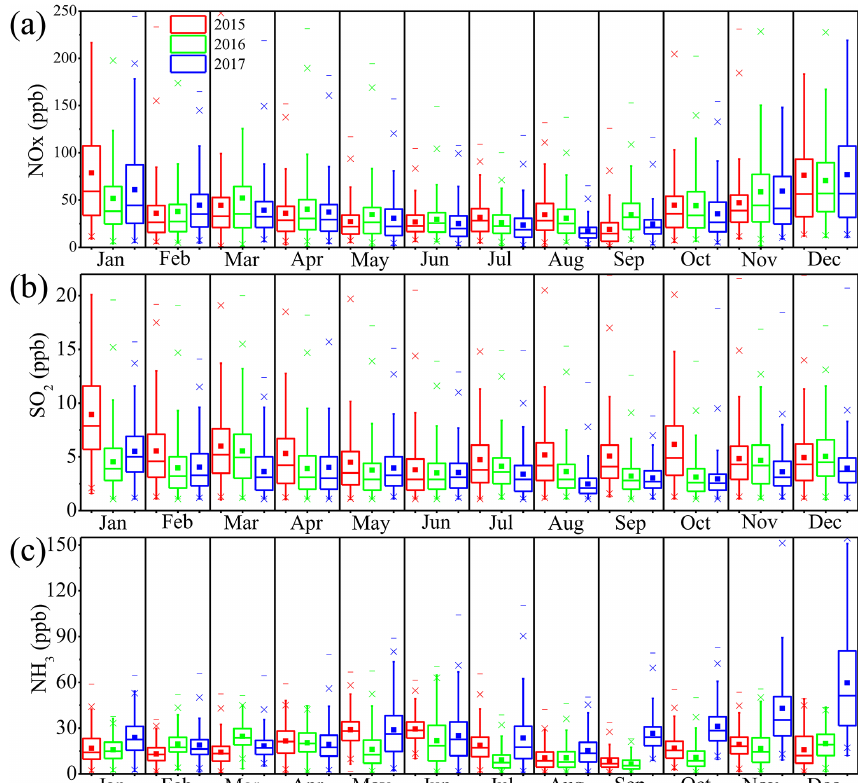
Figure 4. Monthly variations in NO x , SO 2 and NH 3 concentrations from 2015 to 2017. (a) NO x . (b) SO 2 . (c) NH 3